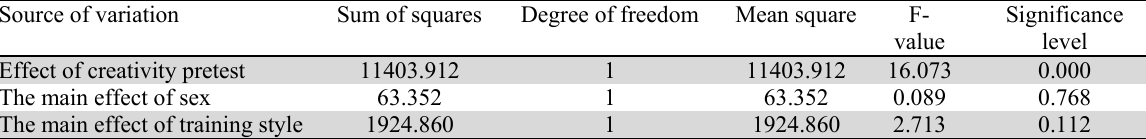
The effect of the educating method of Ban Ben Bon on creativity of male and female preschool children Source of variation Sum of